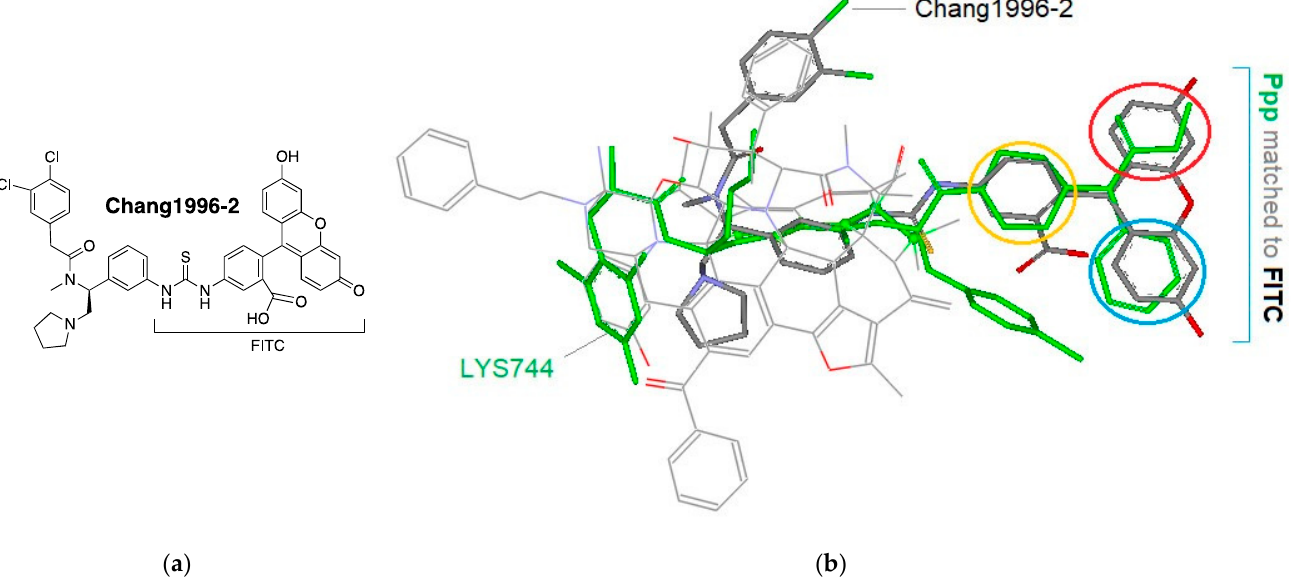
Figure 5. Structural correlation between 6 ( LYS744 ) and Chang1996-2. The structure of Chang1996-2 ( a ) and co-alignment of Chang1996-2 (grey) and 6 (light green) with the template ( b ).